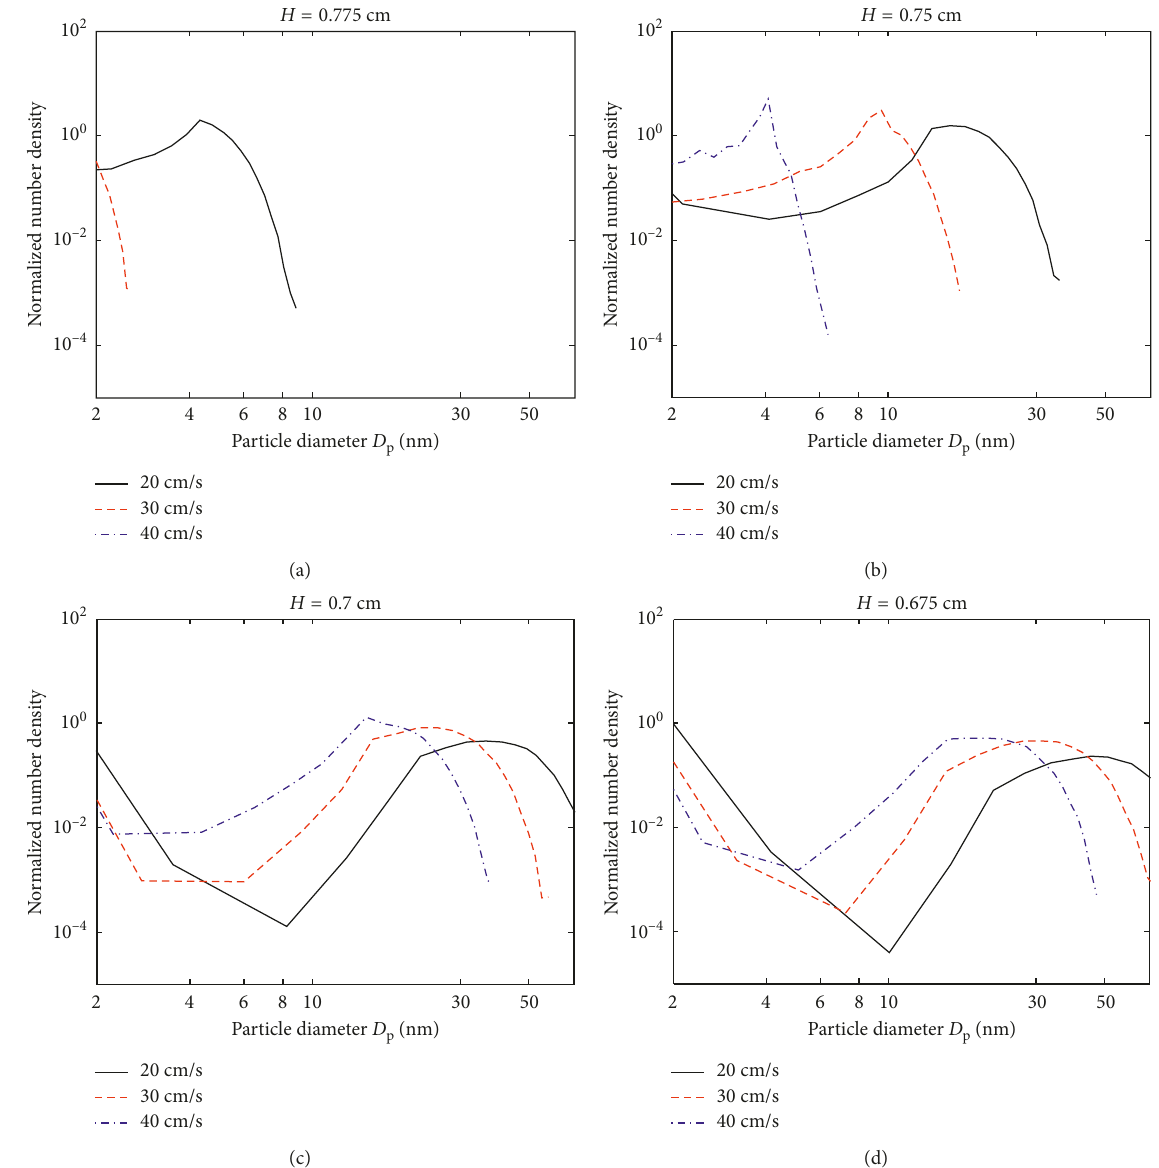
Figure 8: Normalized number density distribution under various exit velocities at different heights from the fuel nozzle H . (a) H (b) H 0 . 75cm, (c) H 0 . 7cm, (d) H 0 . (cid:28) (cid:28) (cid:28)